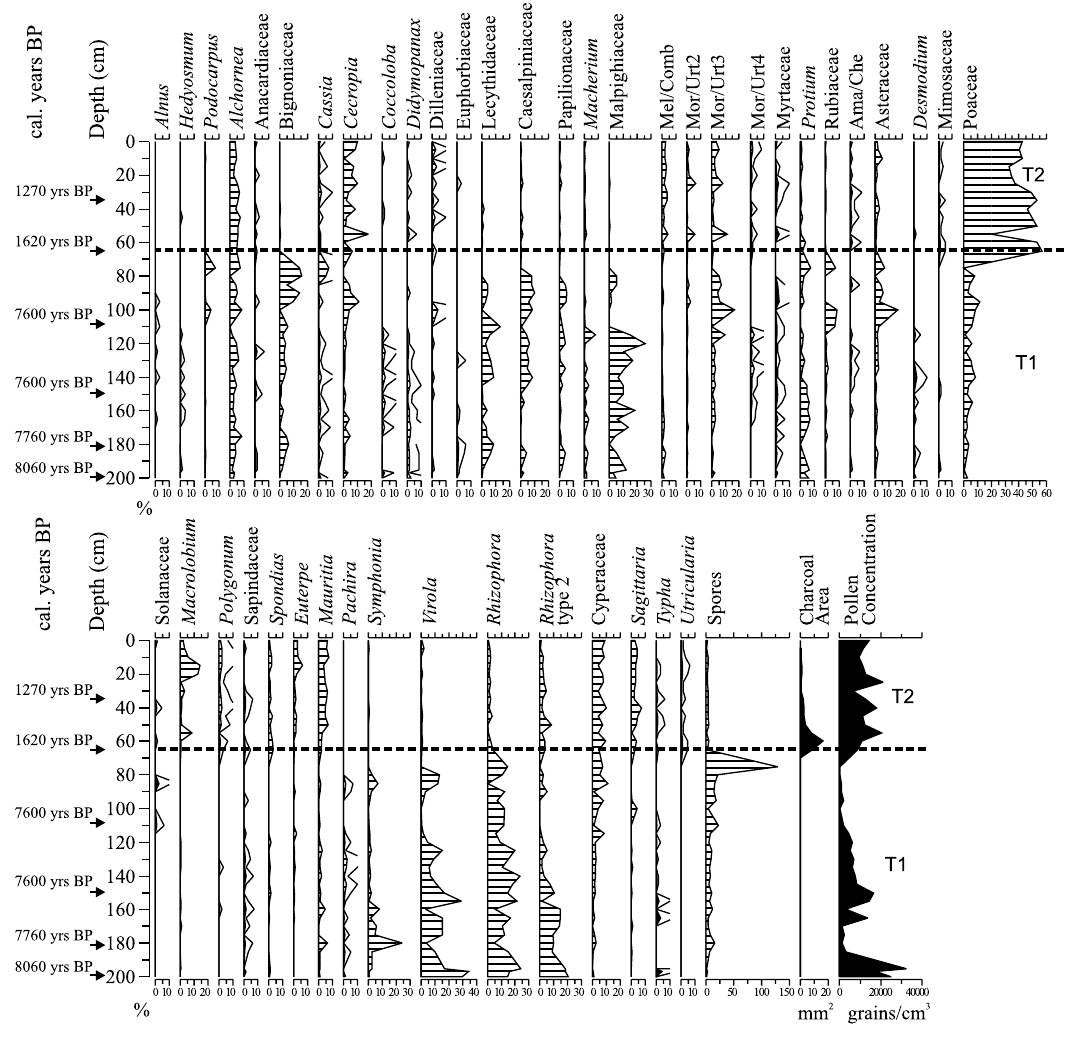
Fig. 4 – Pollen percentage diagram of Lake Tapera, Amapá (Brazil), showing the most representative taxa, including Andean taxa, area of charcoal particles (mm 2 /cm 3 of sediment), pollen concentration (grains/cm 3 of sediment), and radiocarbon dates (cal. years BP). The hollow curves are exaggerated 5